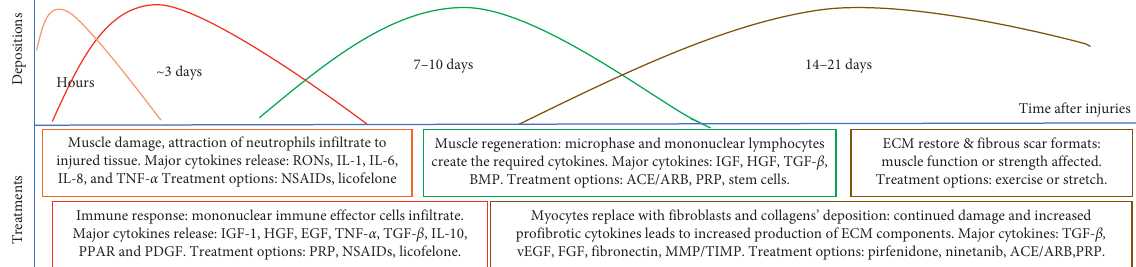
ECM restore & fibrous scar formats: muscle function or strength affected. Treatment options: exercise or stretch.